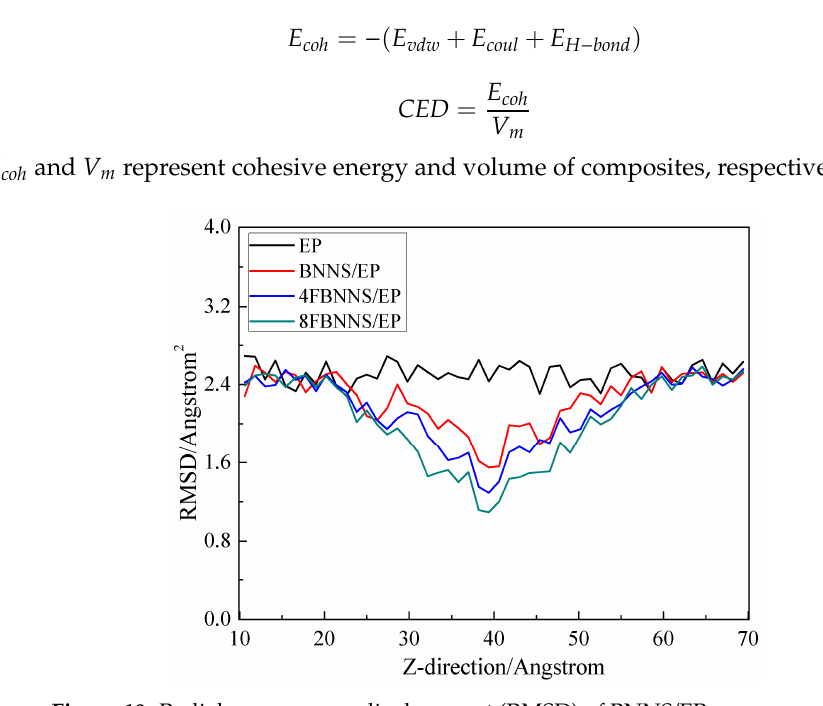
Figure 9. Mean square displacement (MSD) of BNNS/EP nanocomposites.